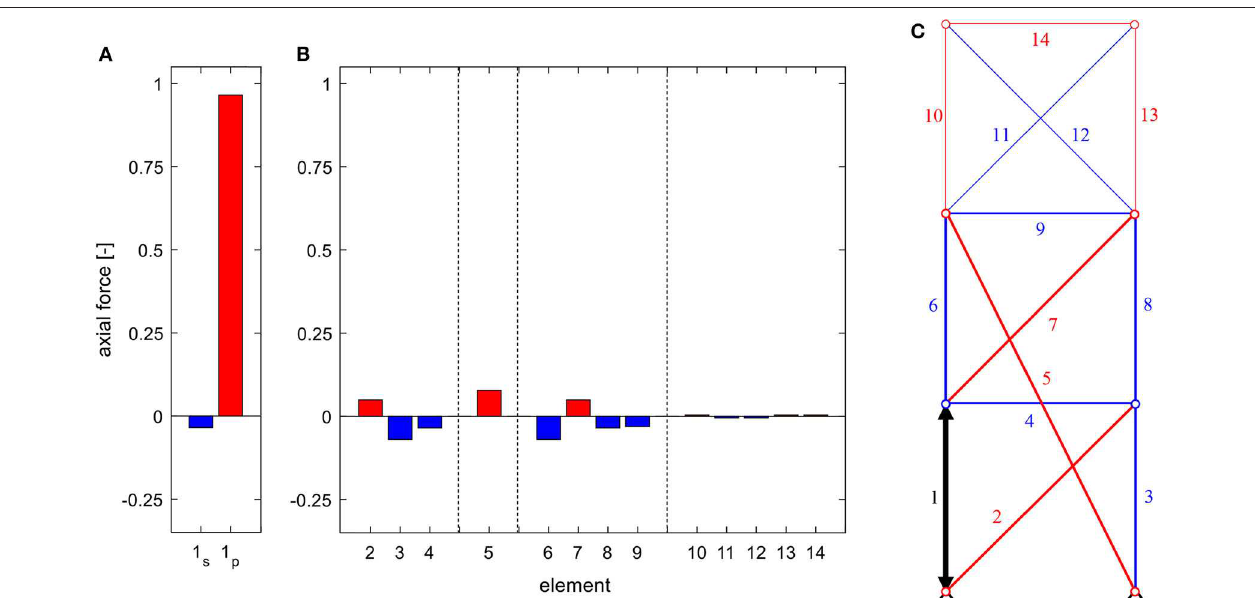
FIGURE 12 | Axial forces in (A) the actuated element for serial (index s ) and parallel (index p ) linear actuation, (B) the remaining structure due to the actuation of element 1 (C) , for a truss with module-overlapping